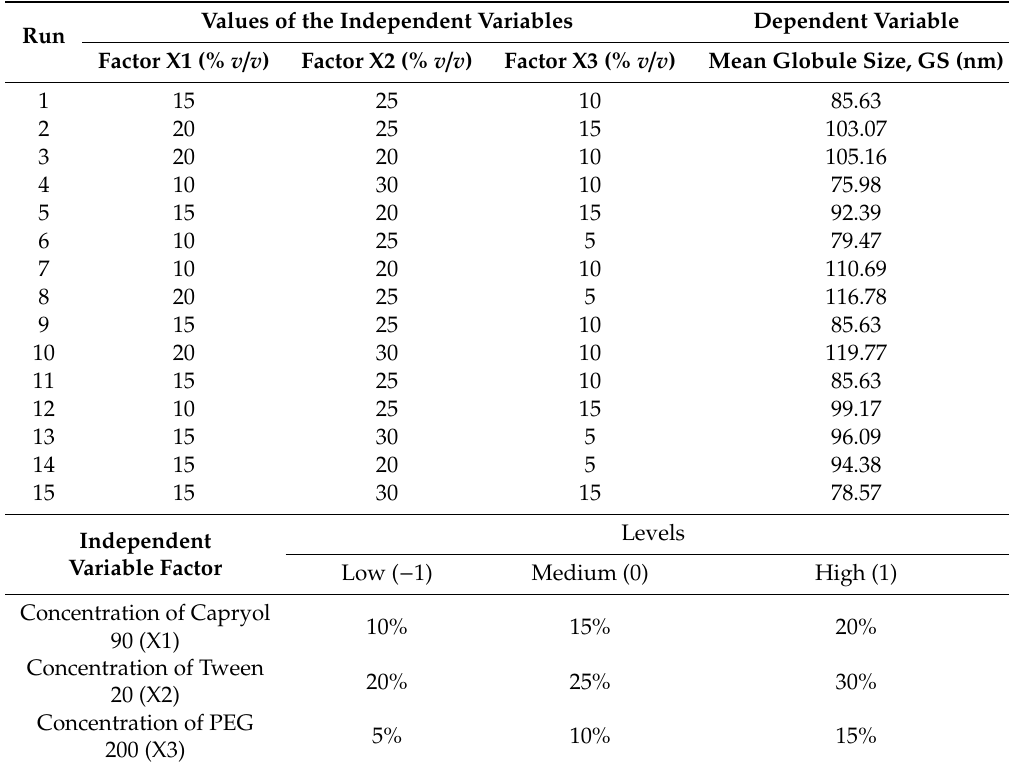
Table 1. Independent variables with the coded values, the dependent variable, and the responses obtained for the various formulation trials.